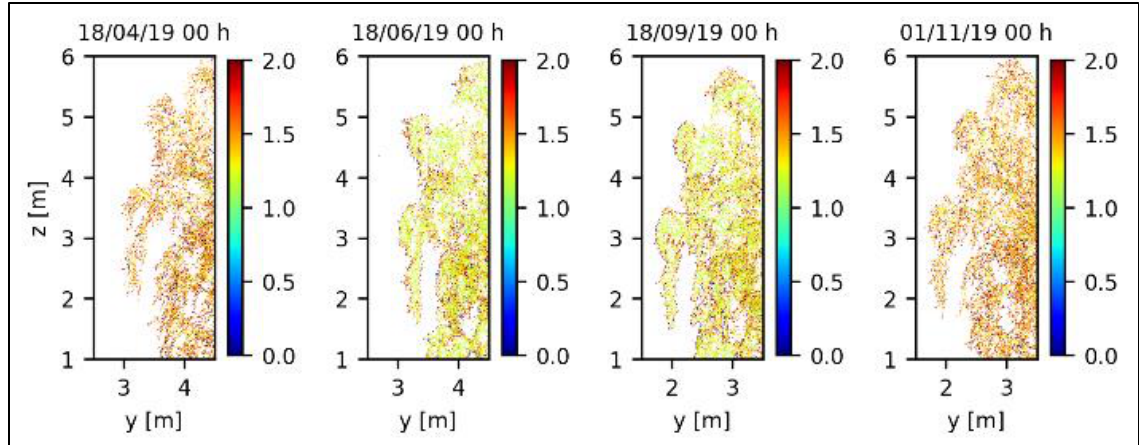
Figure 7. Seasonal variation in a Silver Birch branch measured with two to three month intevals between April and November in 2019. The colour scale shows point reflectance in logarithmic scale (0 –